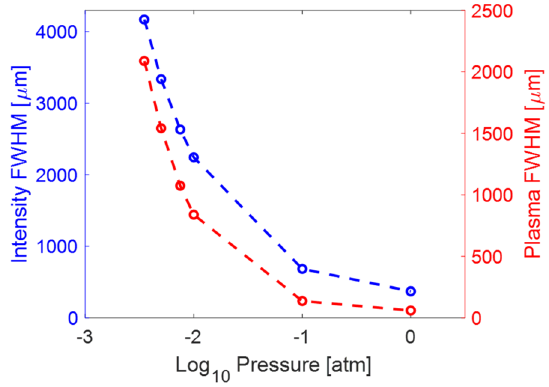
Figure 4. Simulation results of the filament intensity FWHM (blue) and the plasma channel FWHM (red) as a function of